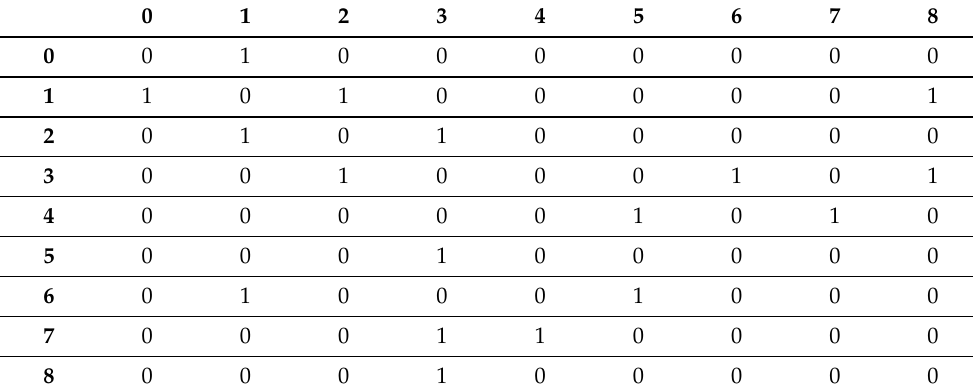
Table 4. Example of filling a relationship matrix M